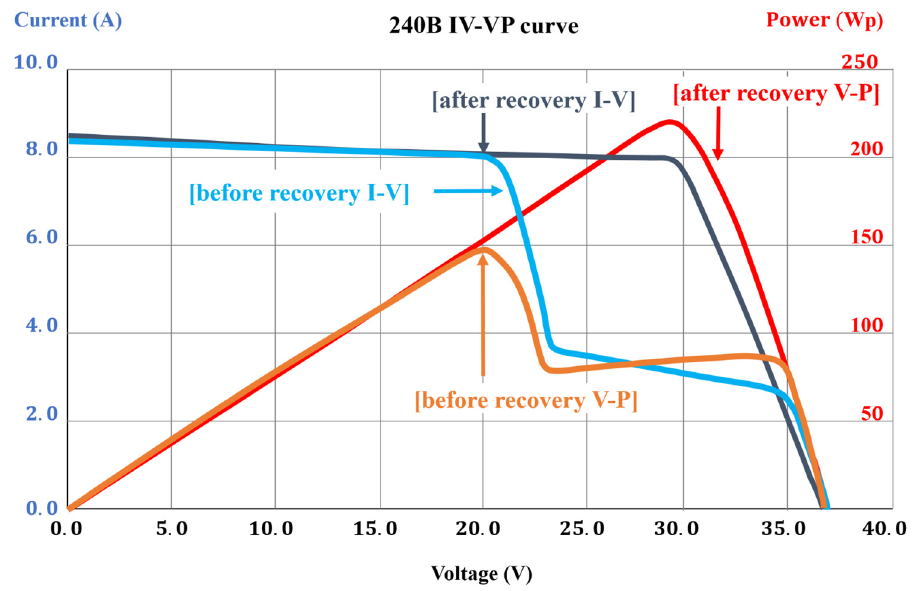
Figure 13. I–V and V–P curves in the module before and after recovery (240B).